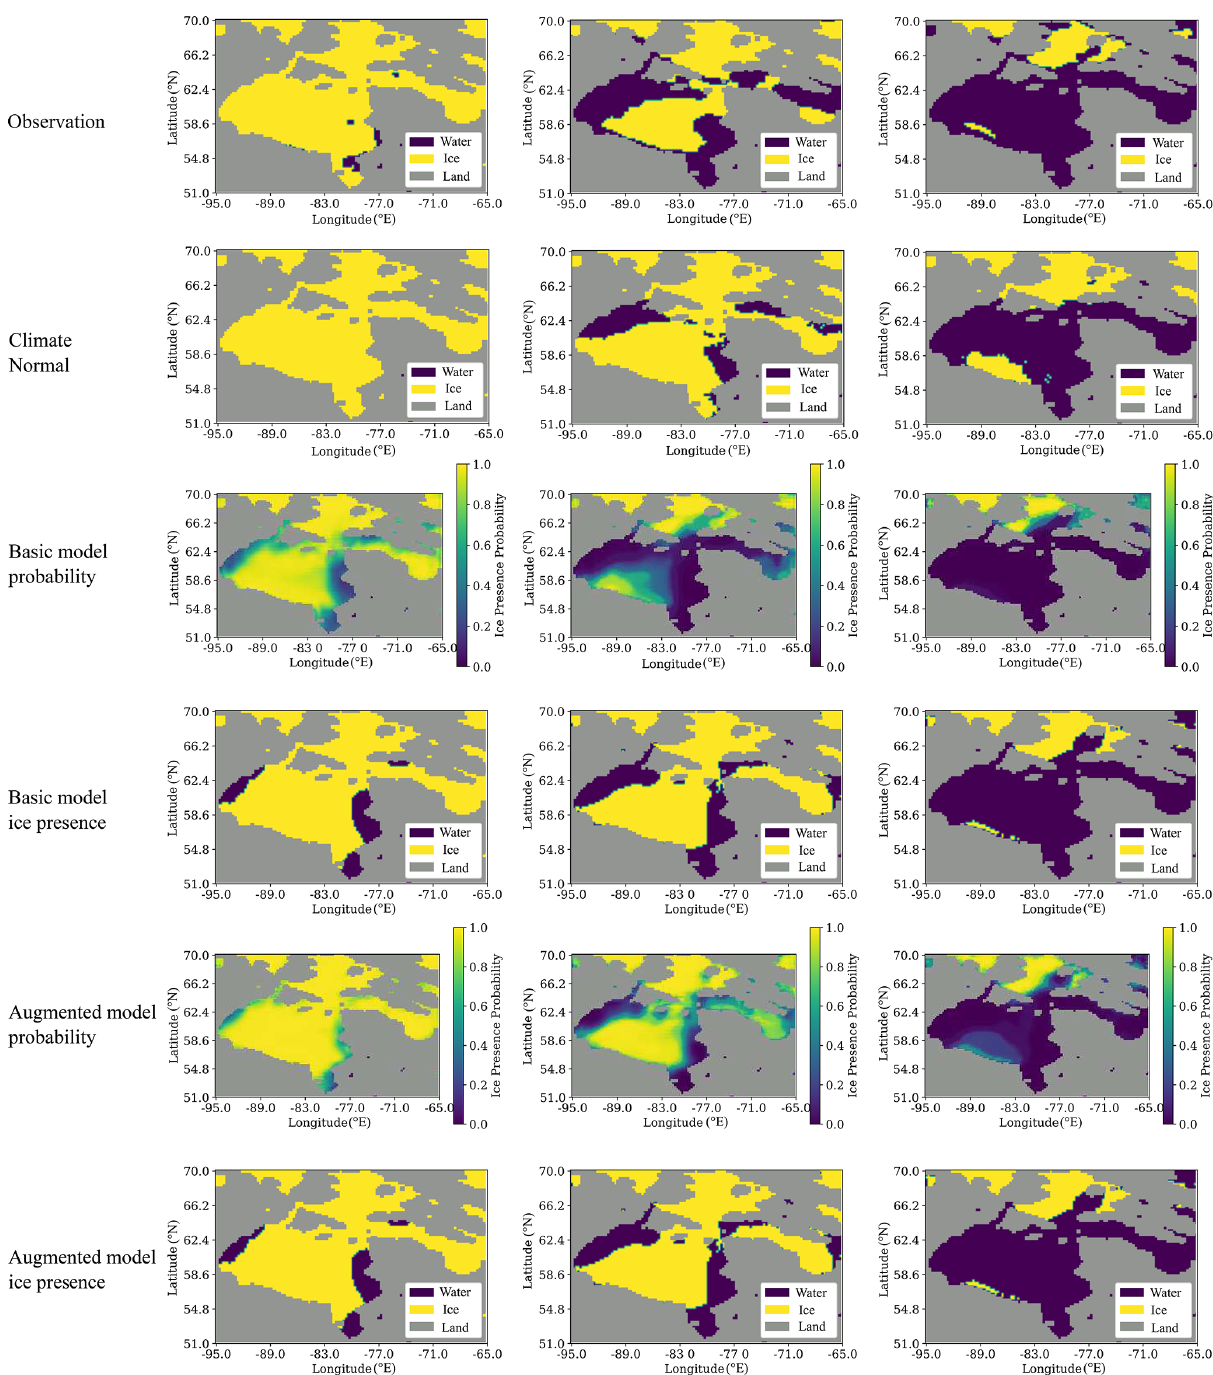
Figure 7. Spatial patterns of sea ice presence during breakup. These models are trained using data from May, June, and July. The forecasts are launched on 6 May 2014 and are displayed after 30d (5 June, left column), 50d (25 June, middle column), and 70d (15 July, right